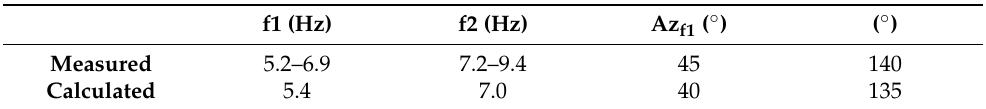
Table 1. Experimental and modeled resonance frequencies f1 and f2 and related average azimuths of vibration from N direction (quartzite Young’s modulus = 25